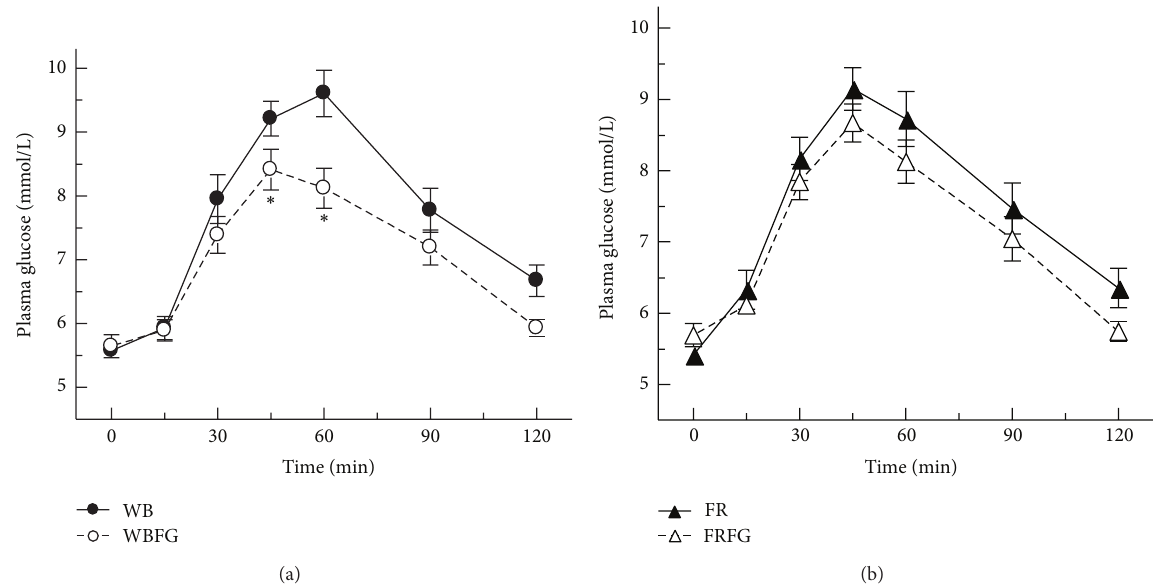
Figure 1: (a) Mean plasma glucose response of white bread and white bread with fenugreek. Values are means ± SEM ( 𝑛 = 14 ). Comparison of plasma glucose concentrations ( ∗ 𝑃 < 0.05 ). WB: white bread; WBFR: white bread with fenugreek. (b) Mean plasma glucose response of fried rice and fried rice with fenugreek. Values are means ± SEM ( 𝑛 = 14 ). Comparison of plasma glucose concentrations. FR: fried rice; FRFG: fried rice with fenugreek.